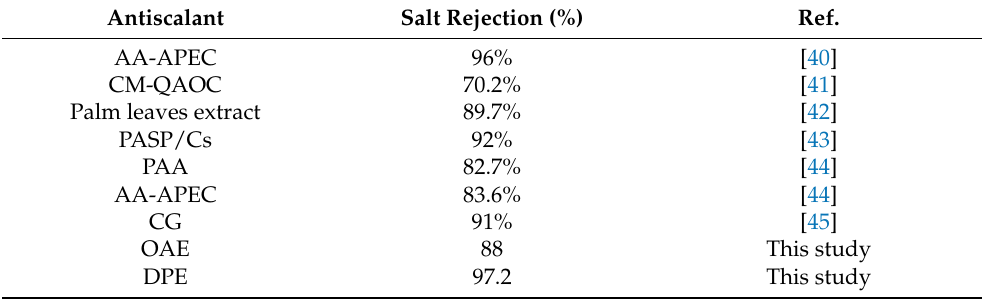
Table 2. Comparison of OAE and DPE efficiency with some calcite scale inhibitors of previous studies. Antiscalant Salt Rejection (%) Ref. AA-APEC 96% [40] CM-QAOC 70.2% [41] Palm leaves extract 89.7% [42] PASP/Cs 92% [43] PAA 82.7% [44] AA-APEC 83.6% [44] CG 91% [45] OAE 88 This study DPE 97.2 This